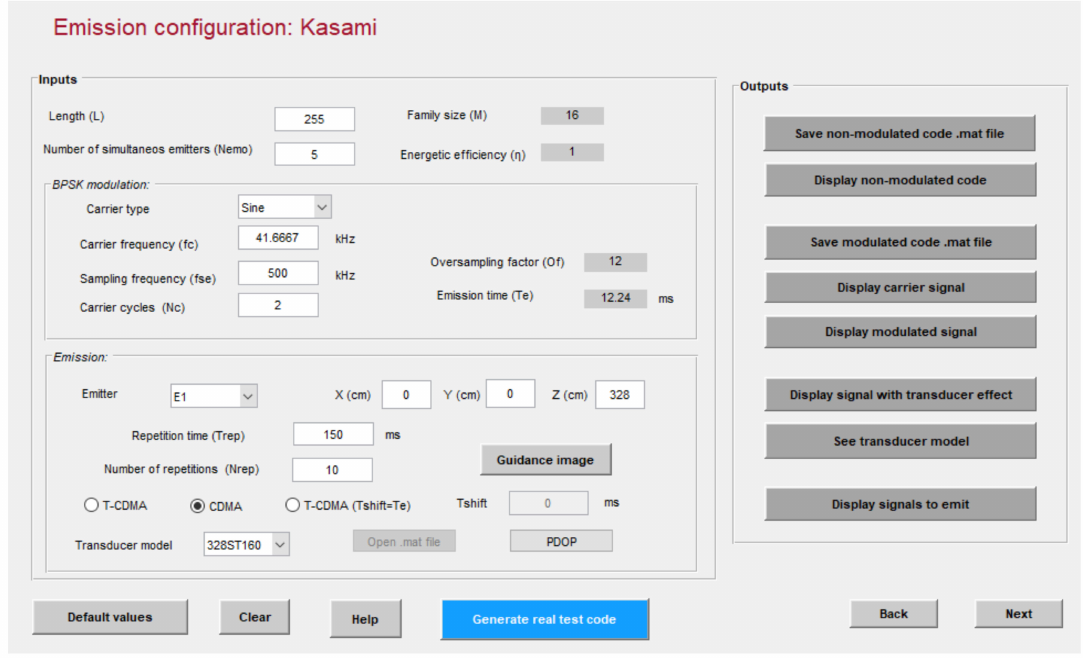
Figure 2. Example of emission configuration with five 255-bit Kasami codes modulated in BPSK with two carrier cycles at 41.67 kHz and a sampling frequency of 500